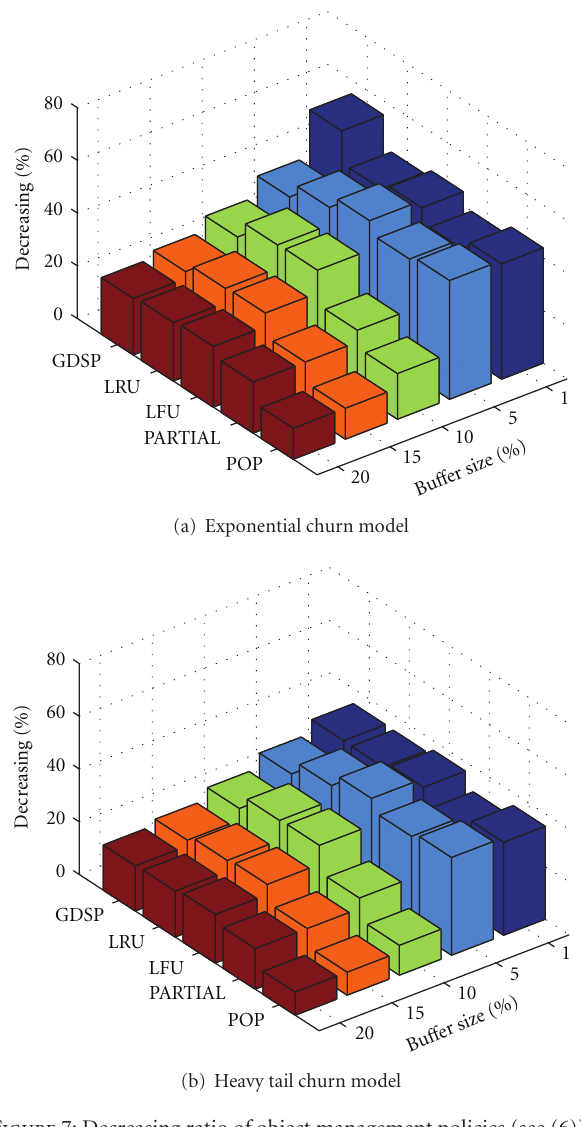
Figure 7: Decreasing ratio of object management policies (see (6)).